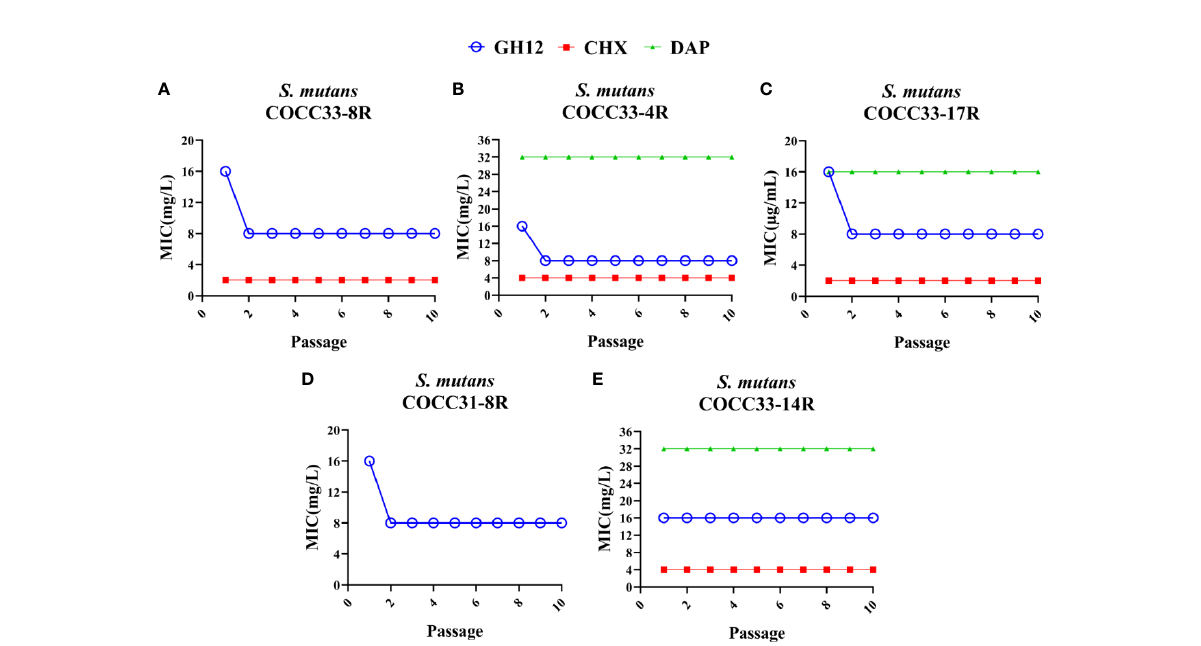
FIGURE 2 Evaluation of the stability of acquired resistance of S. mutans clinical strains. MIC values of GH12, CHX and DAP to S. mutans COCC33-8R (A) , COCC33-4R (B) , COCC33-17R (C) , COCC31-8R (D) and COCC33-14R (E) after each passage regrown in the lack of antimicrobial agent, respectively (mean ± SD; n = 3). R, resistant